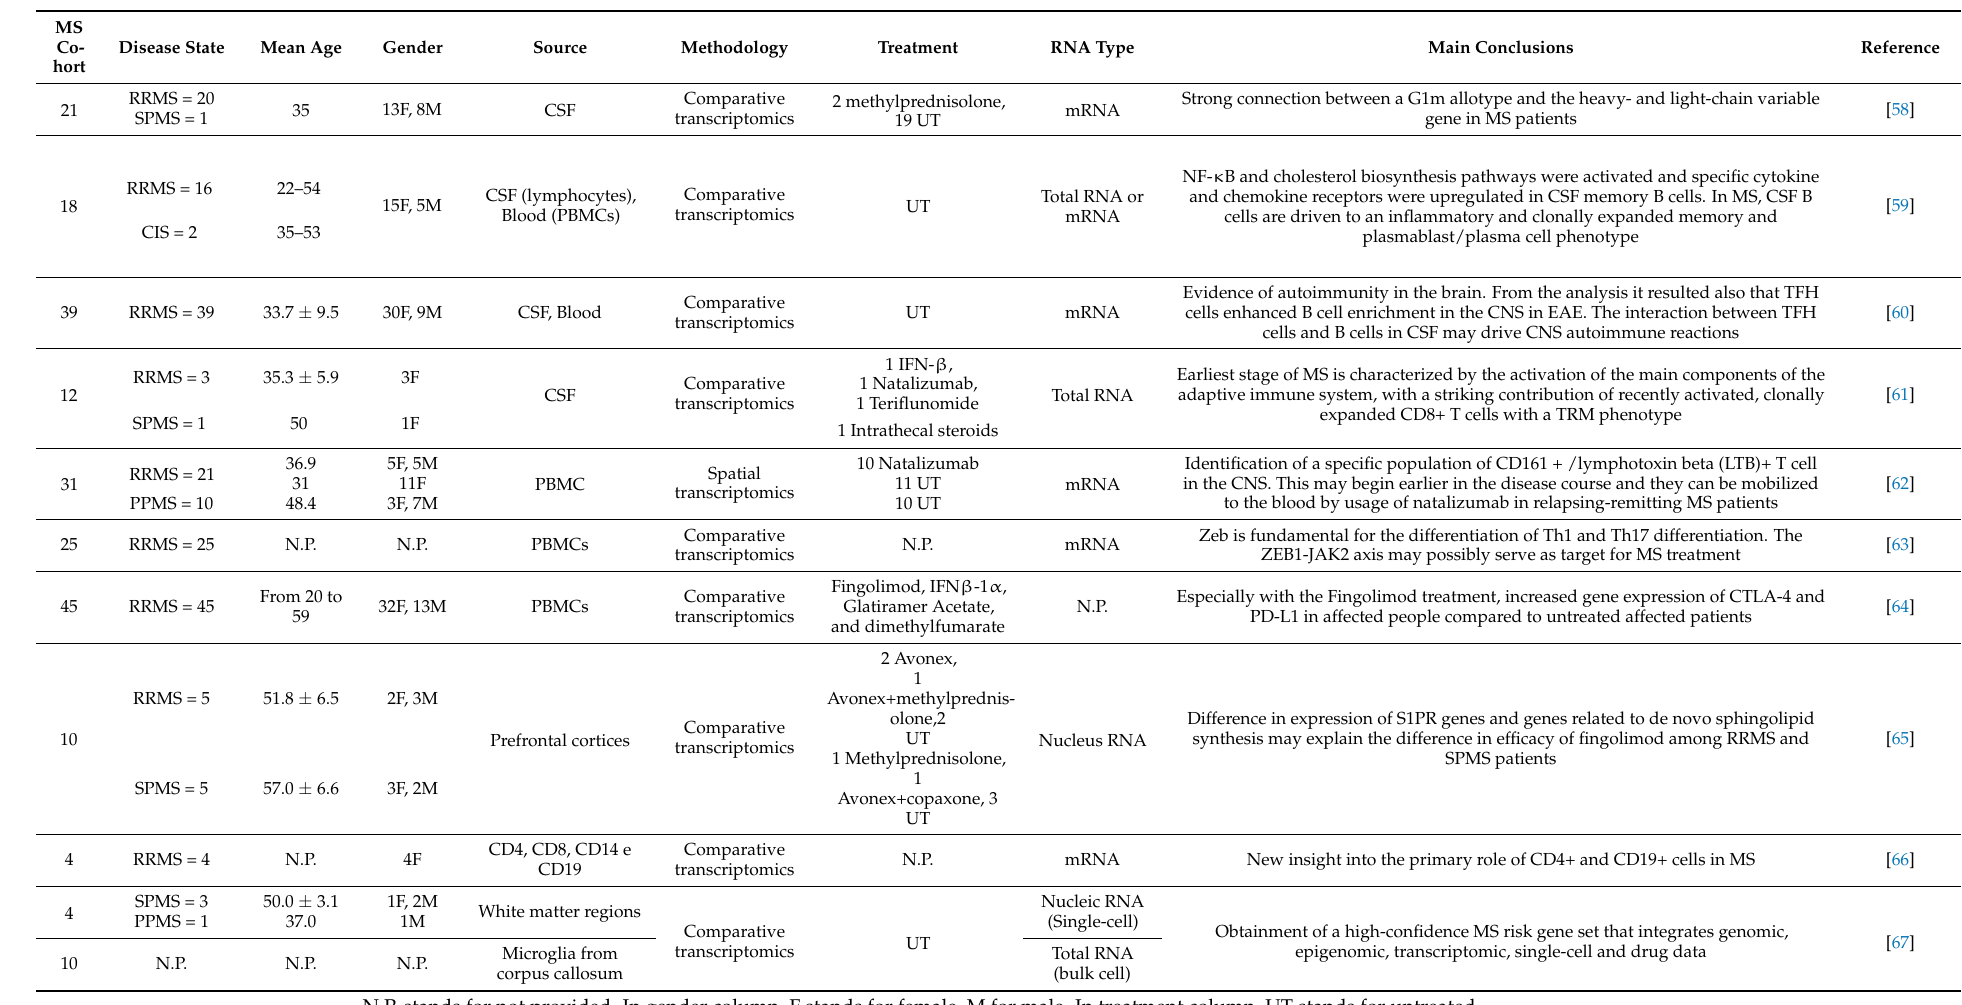
Table 7. Overview of the studies exploring transcriptomes in